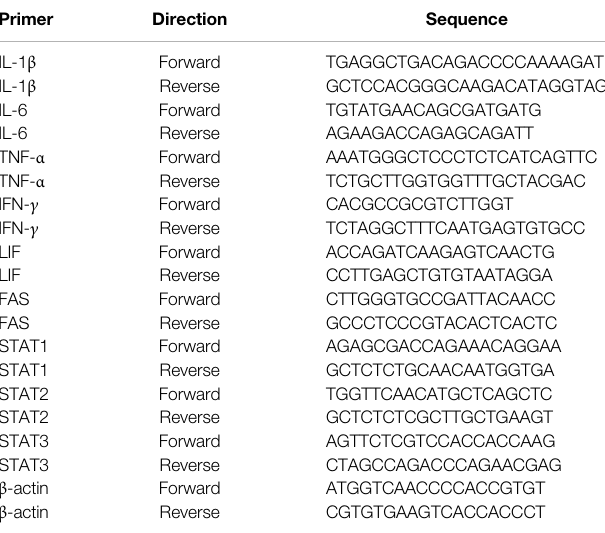
TABLE 1 | Primer sequences used for quantitative real time-polymerase chain reaction in the current study. Primer Direction